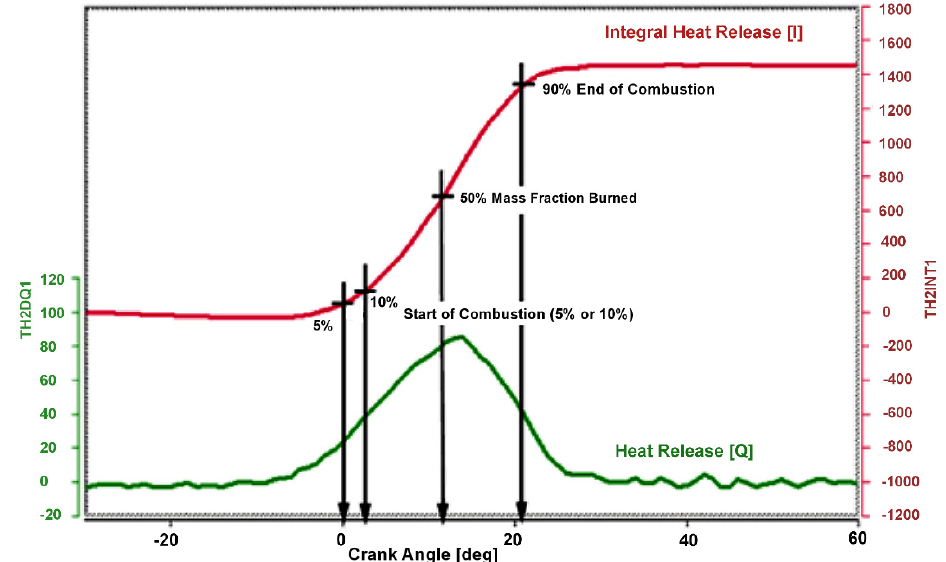
Figure 15. Methodology for the determination of the engine crankshaft rotation angles, at which the fuel dose has been burned out to the degree of 5, 10, 50 and 90% of the total fuel dose injected to the cylinder.